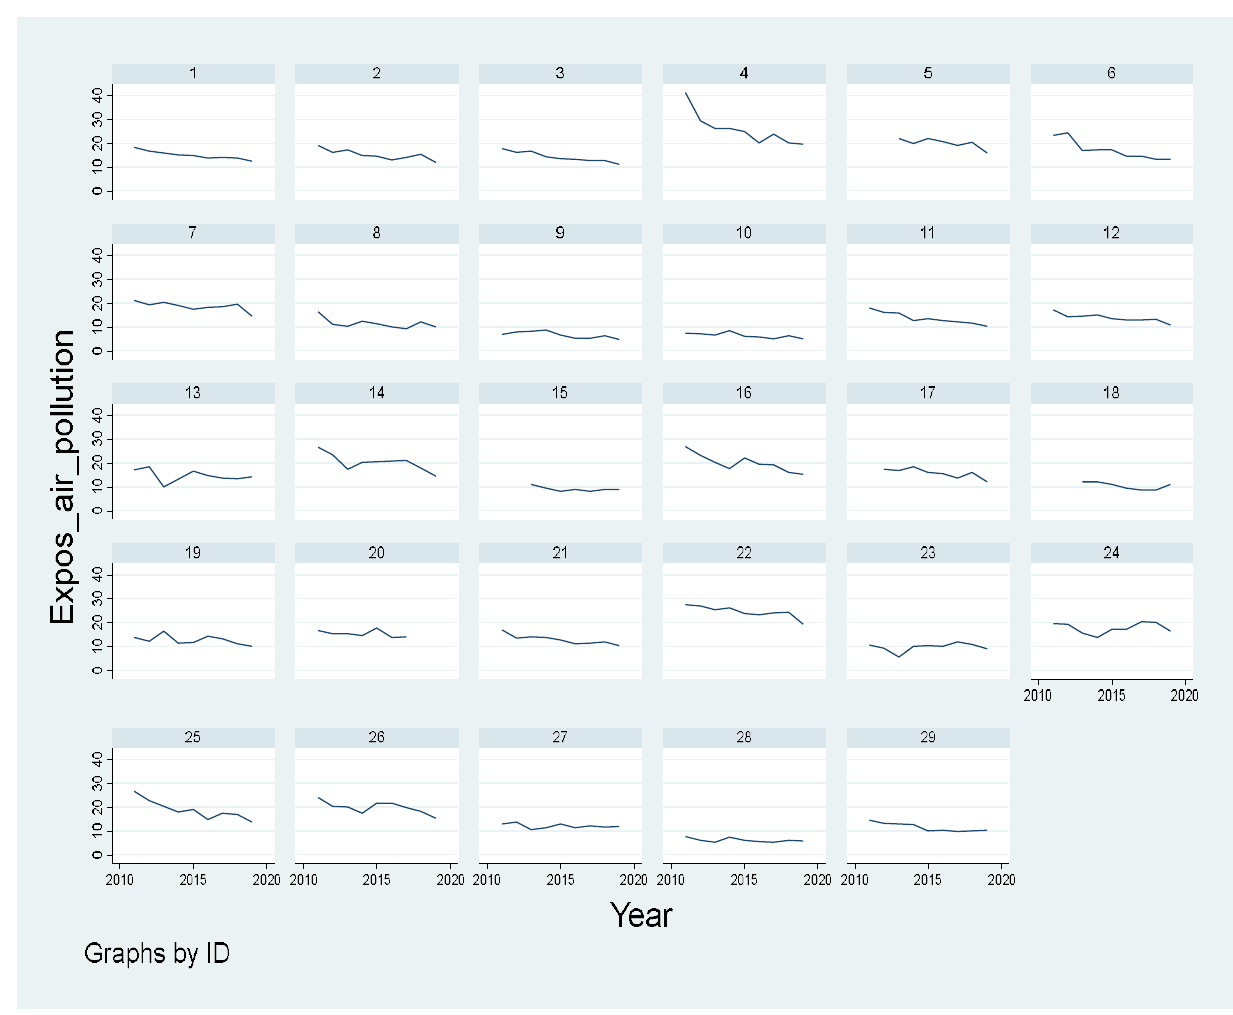
Figure 2. Exposure to air pollution by particulate matter (2011–2019). Source: authors’ representation of the data in Stata graph. Table 5. The influence of the independent indicators on the target